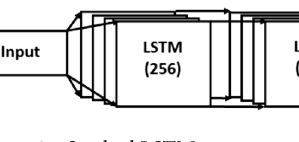
Figure 2. Stacked LSTM structure.